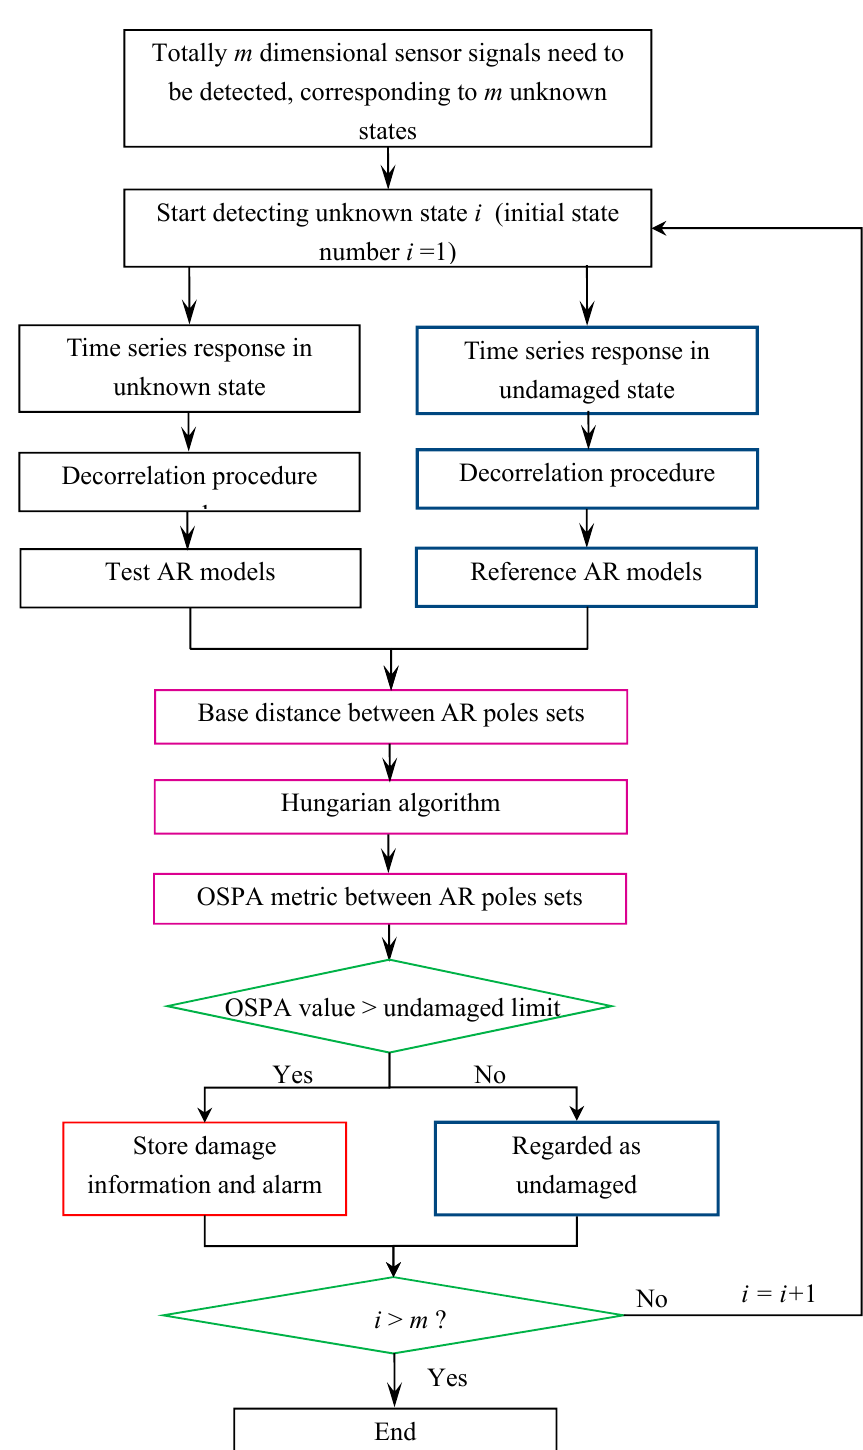
Figure 2. Flowchart of the proposed damage detection methodology.